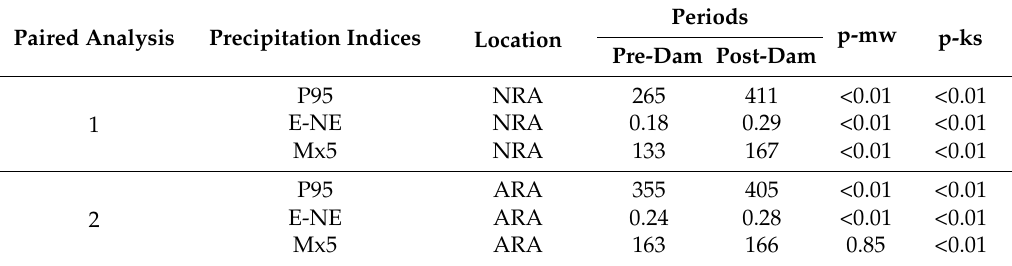
Table 8. Statistical difference tests for the mean and distribution in the extreme rainfall indices